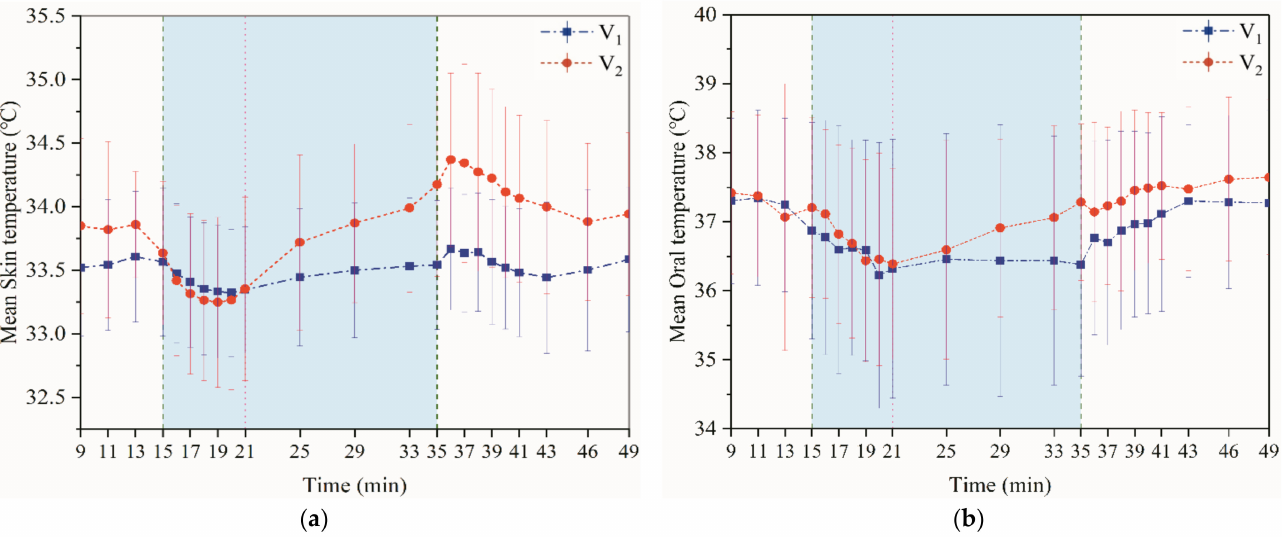
Figure 4. Multiple lines of mean skin and oral temperature (95% CI) by time and phase. ( a ) Mean skin temperature; ( b ) mean oral temperature. (V 1 : 4.5 km/h; V 2 : 6